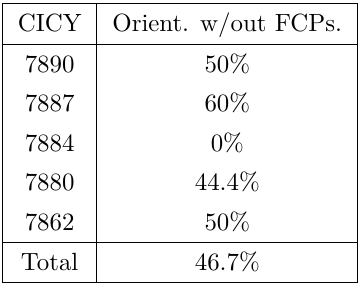
Table 2 . Percentage of orientifolds without frozen conifold points for the 5 CICYs that are also in the KS